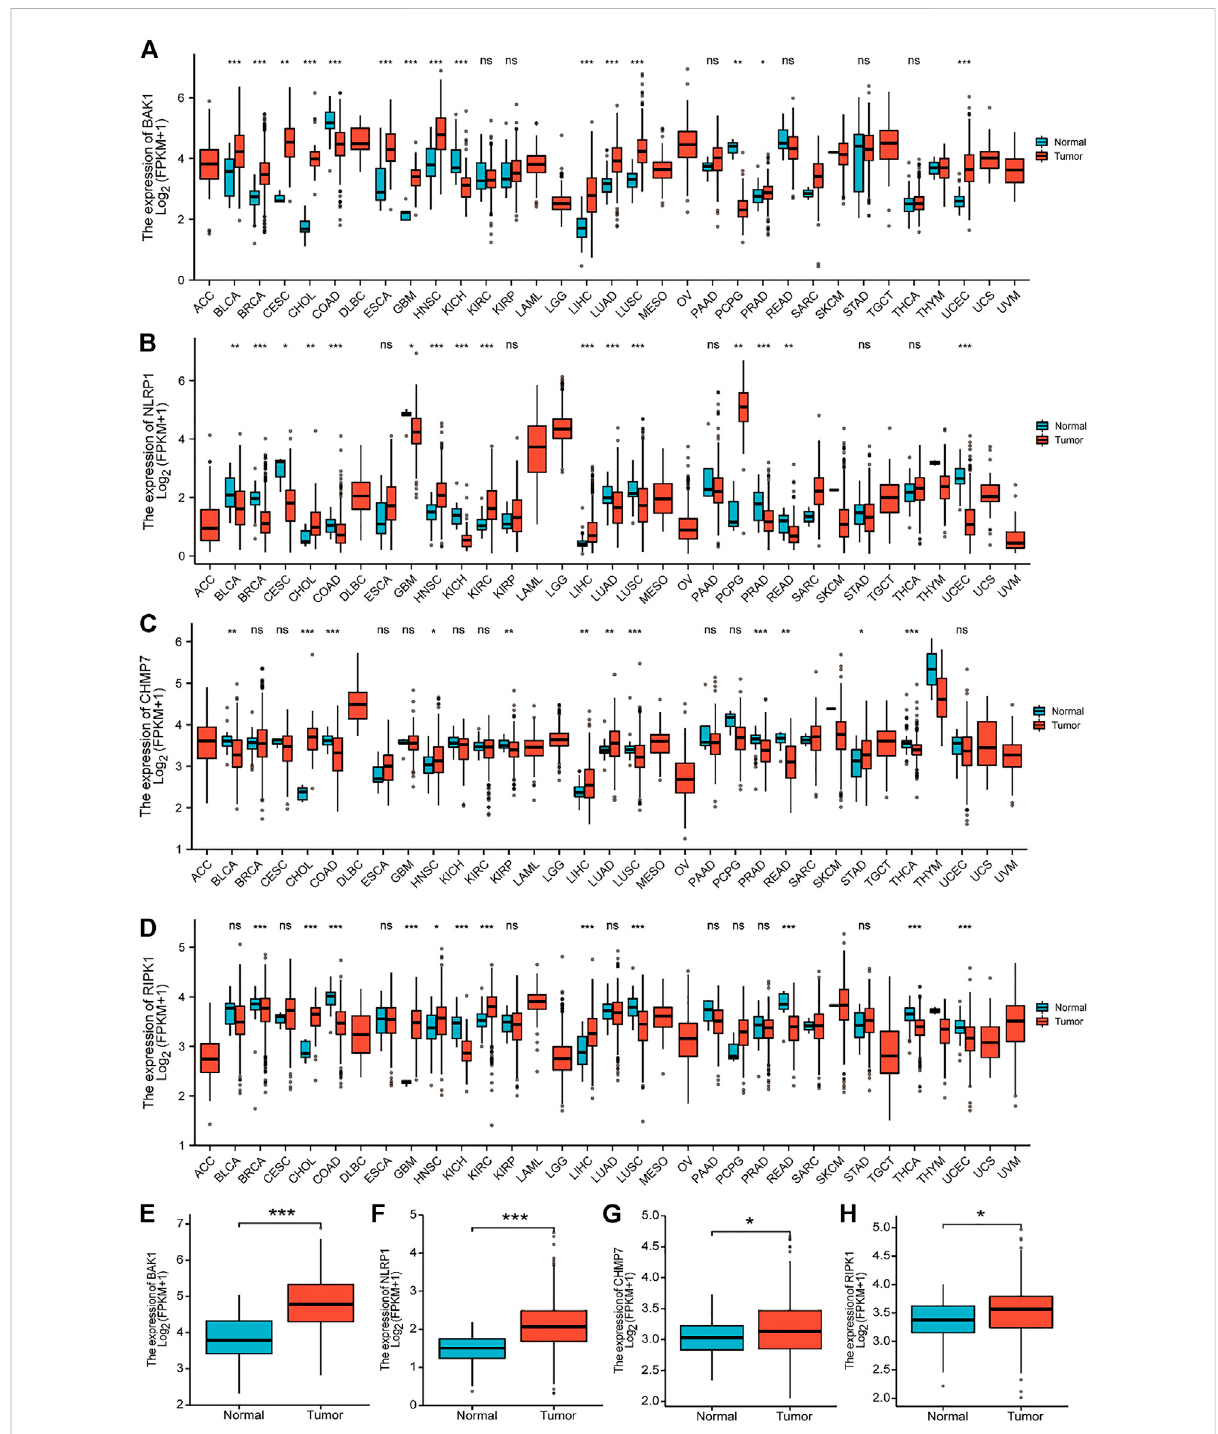
FIGURE 5 Expression of BAK1 , NLRP1 , CHMP7 , and RIPK1 markers in tumors. (A) BAK1 expression in 33tumor species in theCancer Genome Atlas(TCGA) database; (B) ExpressionofNLRP1intumorof33speciesintheTCGAdatabase; (C) CHMP7expressionin33tumorspeciesintheTCGAdatabase; (D) TCGA database of RIPK1 expression in 33 tumor species; (E) BAK1 expression is increased in head and neck squamous cell carcinoma (HNSCC) tissues; (F) NLRP1 expression is elevated in HNSCC tissues; (G) CHMP7 expression is elevated in HNSCC tissues; (H) RIPK1 expression was elevated in HNSCC tissues. * p < 0.05, ** p < 0.01, *** p <